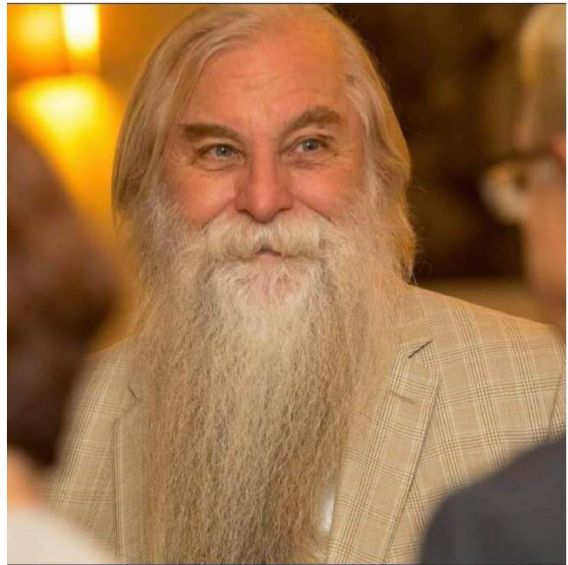
Figure 2. Dr. Randall J. Cohrs. Photo permitted for use by the Cohrs